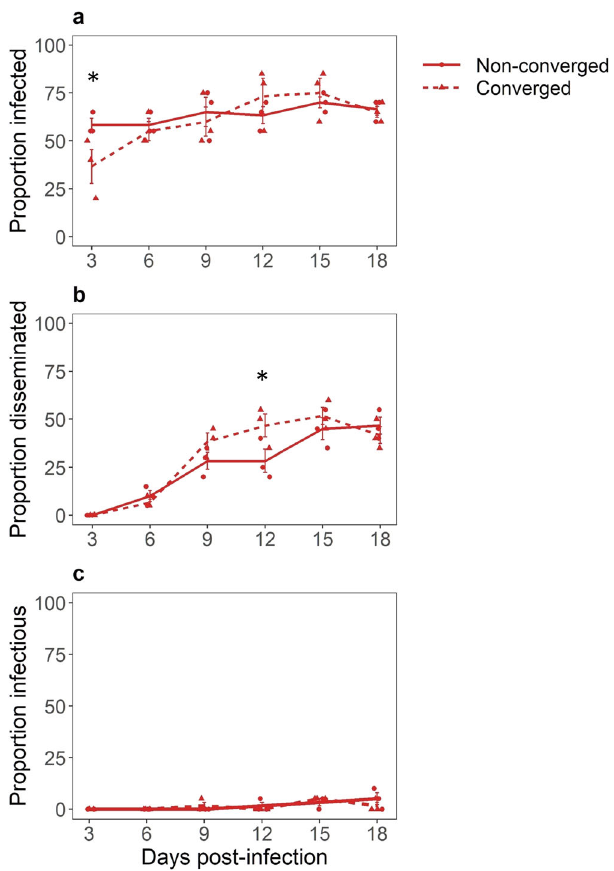
Fig. 3 The effect of harmonic convergence on dengue-2 virus infection. The effect of parental convergence status (Non-converged, solid lines; Converged, dotted lines) on different metrics of dengue-2 virus (DENV) infection in female Aedes aegypti offspring. a Proportion of infected mosquitoes with DENV positive bodies on days 3, 6, 9, 12, 15, and 18 post infection ( n = 720 observations). b Proportion of mosquitoes with disseminated infection, with DENV positive heads and legs on 3, 6, 9, 12, 15, and 18 days post-infection ( n = 448 observations). c Proportion of infectious mosquitoes with DENV positive saliva on 3, 6, 9, 12, 15, and 18 post infection ( n = 206 observations). Data points represent mean values for each treatment and each biological replicate with error bars showing standard error of the overall mean at each time point post infection. Signi fi cant differences in infection and dissemination rate at a certain time point are indicated by asterisks ( p < se = 1.16, z -value = 3.97, p = <0.001; quadratic: effect, estimate = − 3.01, se = 1.16, z -value = − 2.59, p = 0.01). This increase was due to the proportion of mosquitoes infected at 12, 15, and 18 dpi relative to earlier time points (Fig. 3a). In contrast, the proportion of offspring from non-converging parental pairs did not vary signi fi cantly over time (linear: estimate = 1.64, se = 1.14, z -value = 1.44, p = 0.151; quadratic: estimate = − 0.31, se = 1.14, z -value = − 0.27, p = 0.789) (Fig. 3a). A similar pattern was observed for viral dissemination: the proportion of offspring from converged parents with DENV positive heads/legs changed over time (linear: estimate = 15.32, se = 2.5, z -value = 6.13, p = <0.001; quadratic: estimate = − 9.55, se = 1.97, z -value = − 4.86, p = <0.001) as well as from non-converged parents (linear: estimate = 12.85, se = 2.17, z -value = 5.92, p = <0.001; quadratic: estimate = − 4.66, se = 1.75, z -value = − 2.66, p = 0.008). How- ever, the predicted quadratic effect on the proportion of mosquitoes with disseminated infections was stronger for females